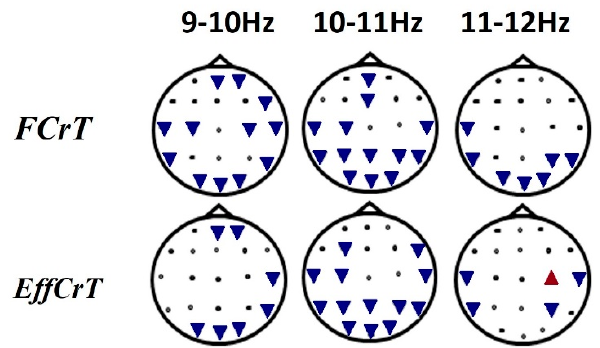
Figure 3. Frequency percentage differences during task fulfillment versus the resting-state condition.